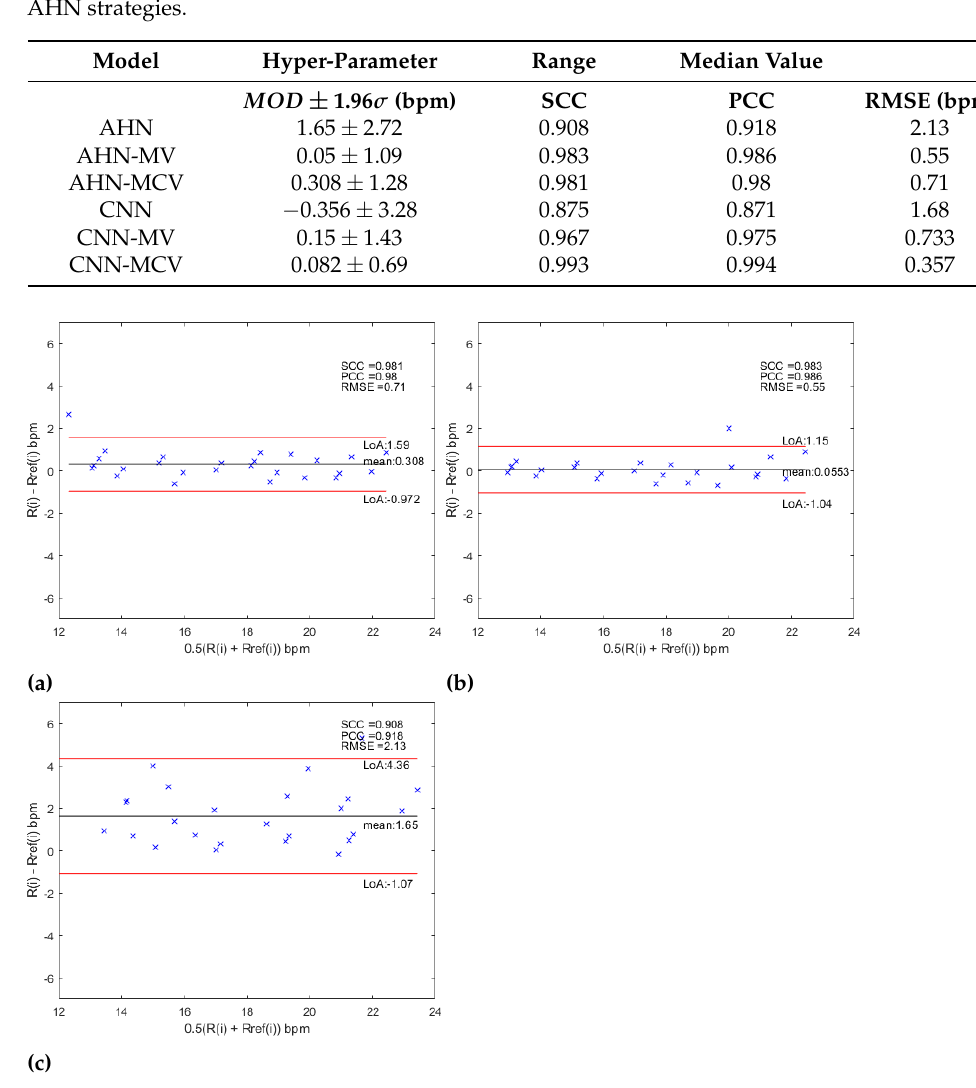
Figure 9. Bland–Altman analysis for ( a ) AHN-MCV, ( b ) AHN-MV and ( c )